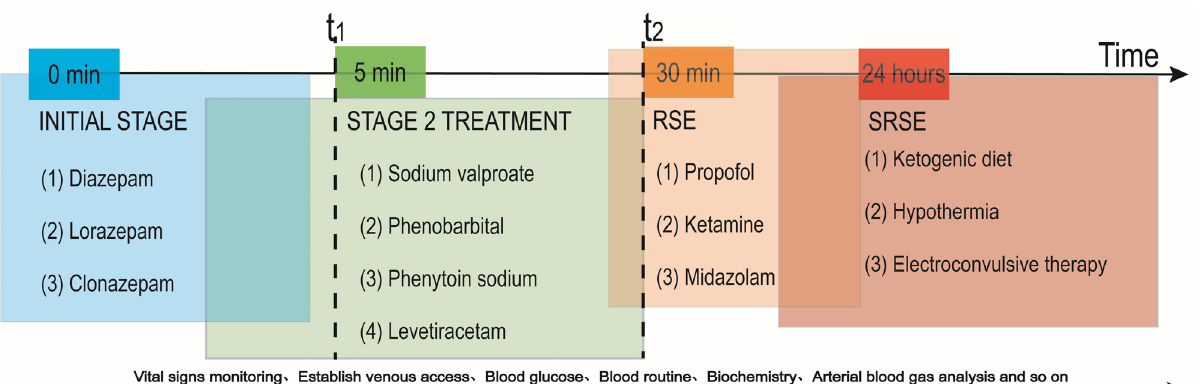
Figure 1. Clinical use of medication at different times during SE attacks. (1) When SE = 0 min, the preferred drugs are diazepam, lorazepam, clonazepam, etc. (2) When 5 min ≤ SE < 30 min, drugs such as phenytoin, valproic acid, or levetiracetam are used as second-line medications. (3) When SE > 30 min, RSE occurs and anesthetics, including propofol, ketamine, and midazolam, can be administered. (4) When SE lasts for 24 h, patients can choose between a ketogenic diet, hypothermia, or electroconvulsive therapy.